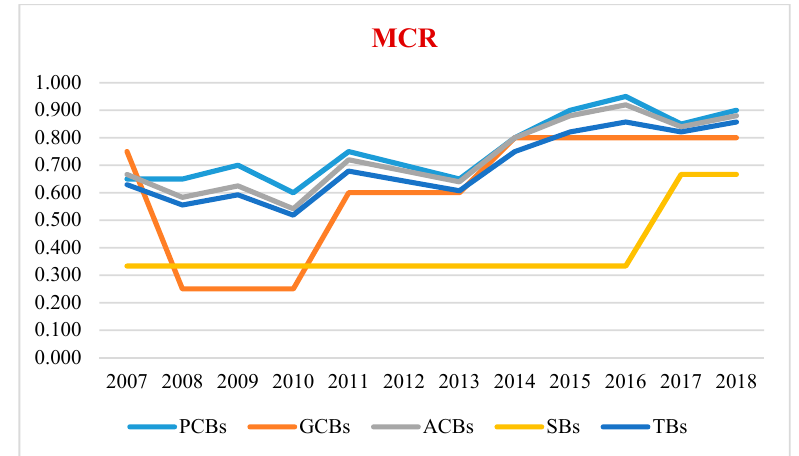
Figure 2. Comparative trends of the Capital Adequacy Ratio (CAR) (during the study period of 2007–2018).